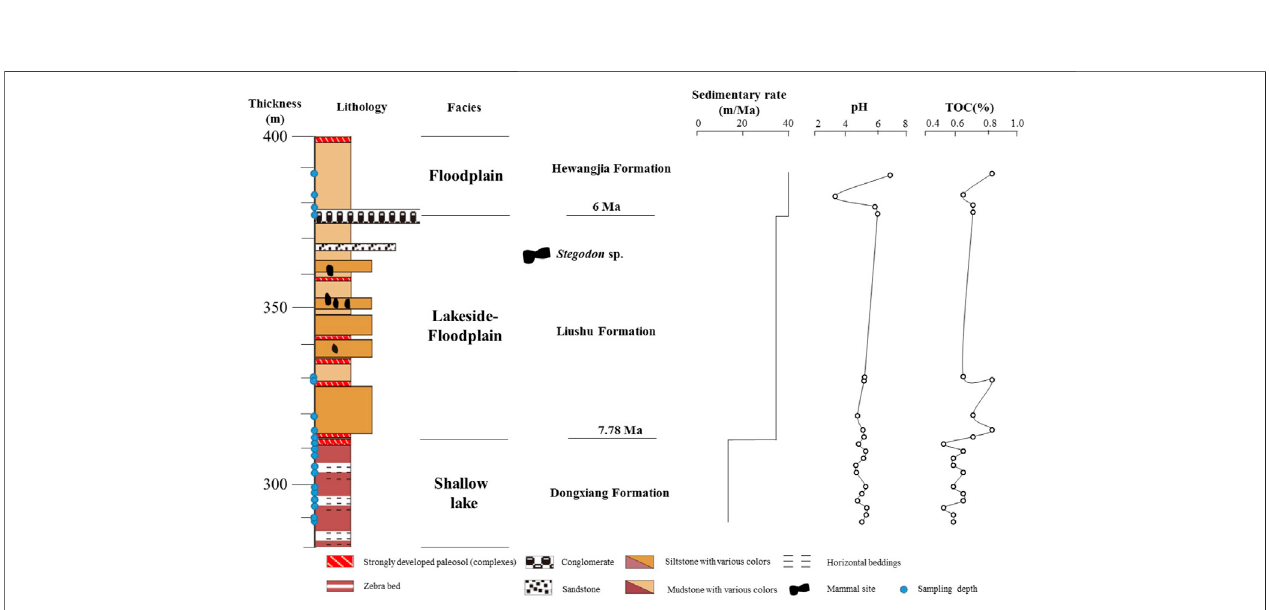
FIGURE 2 | Stratigraphic division, sedimentary facies, lithology (modi fi ed from Fang et al., 2016), sampling depth (solid blue circle), sedimentary rate (He et al., 2020), pH, and total organic carbon (TOC) content in Maogou section.